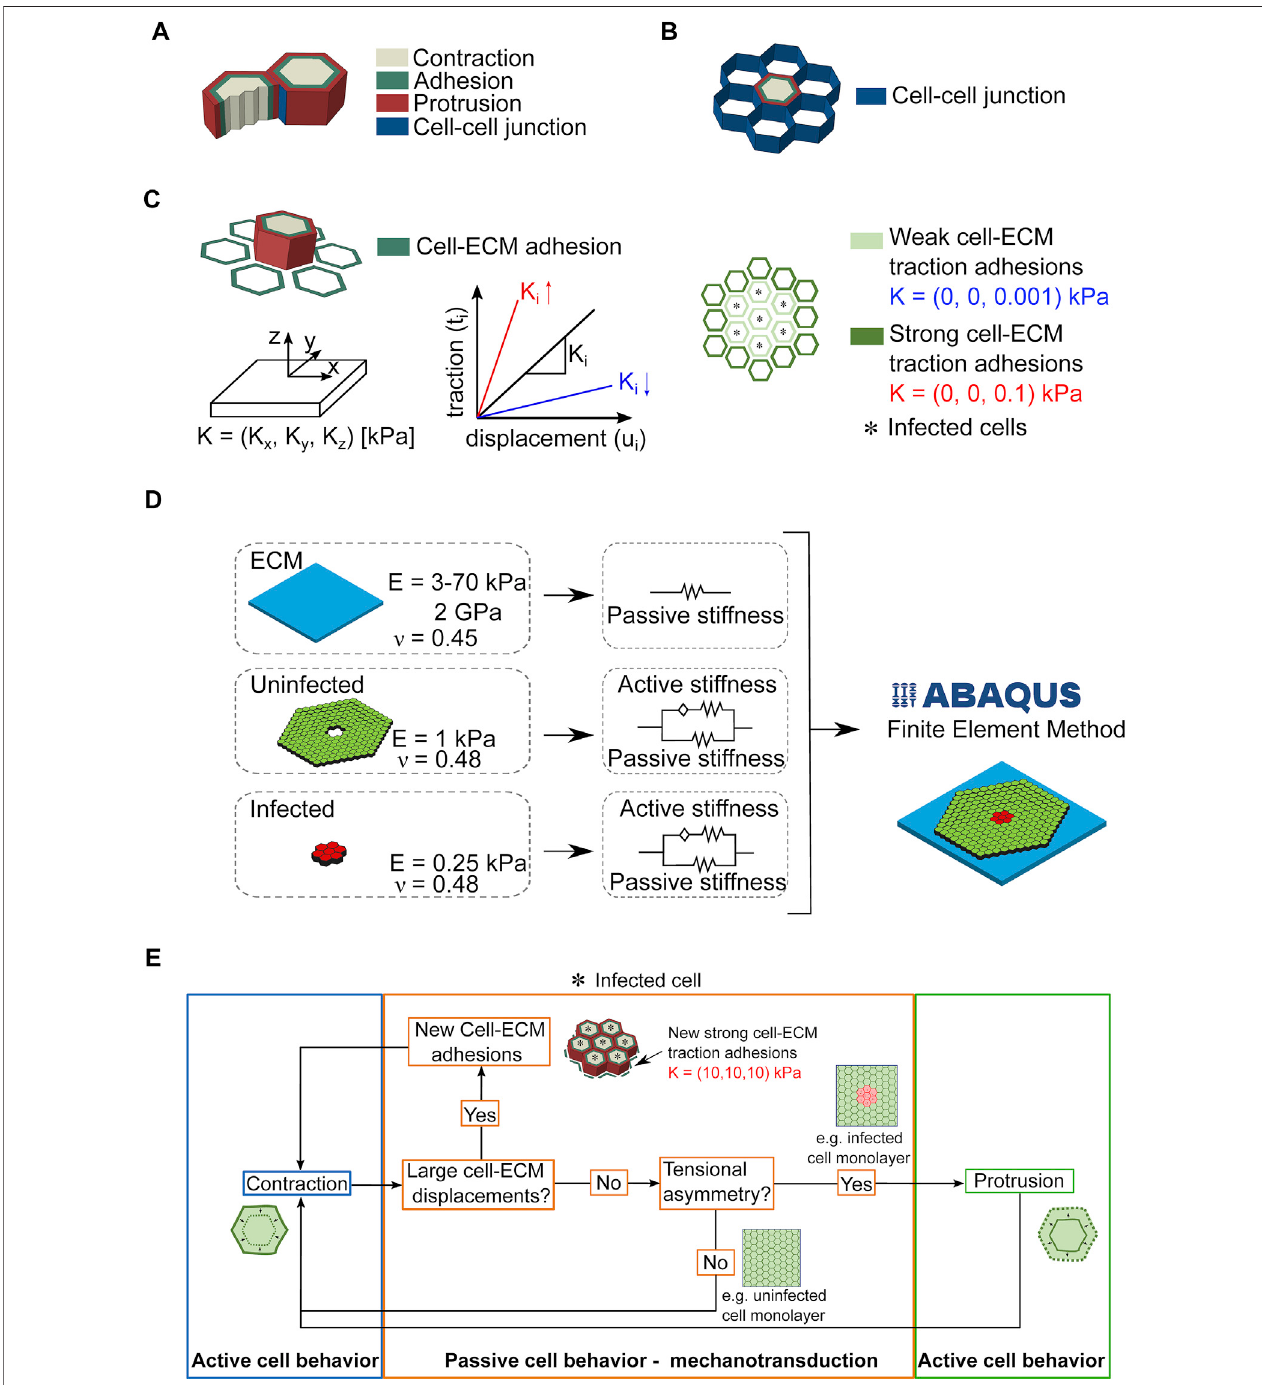
FIGURE3| Considerationsand assumptionsoftheinfection computationalmodel. (A,B) .Sketch showing thatcellsare approximated inthecomputationalmodel ashexagonalprismsthatformcell-celljunctionswithsixneighboringcellsandarepartitionedinthreedomains:contractile,adhesiveandprotrusive (A) .Cell-celljunctions are modeled as linear thin elastic elements (B) . (C) Left schematic illustration shows how the cell produced traction stresses exerted to the ECM are modeled through surface-to-surface contacts between thecelland its ECM. Thestrength ofthetraction adhesions ischaracterizedby K throughits stiffness coef fi cients (K x ,K y ,K z ), withzbeingthenormaldirectiontothesurface,andxandythedirectionsintheplaneofthesurface.Thehigher(lower)thevalueofK i (foriequaltox,yorz),thestronger (weaker) the traction adhesions shown in red (blue). Right schematic illustrates an in silico infection focus with infected cells denoted by an asterisk. In our model, unlike surroundinguninfectedcells,infectedcellsformveryweaktractionadhesionswiththeECM. (D) SketchdepictingthedomainsoftheFiniteElementModel(FEM)usedto computecellulardisplacementsandtractionstressesexertedbycellsontheirECMovertimeandduringbacterialinfection.Themechanicalpropertiescharacterizingthe domains are also shown. (E) Diagram illustrating the cell mechanotransduction mechanism that drives cell kinematics and dynamics in the cell computational model.